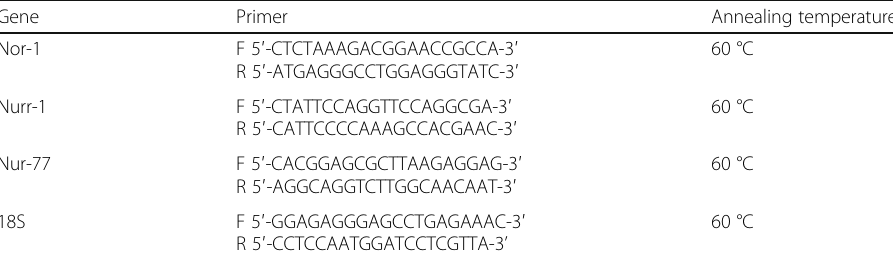
Table 1 Primer sequences used in quantitative